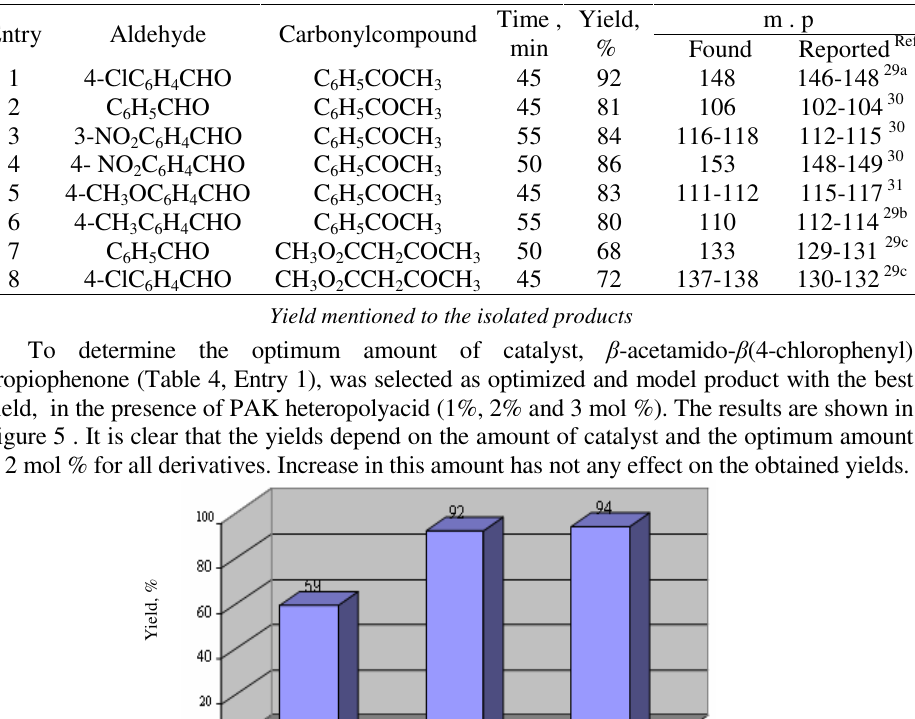
Table 4. synthesis of β -acetamido ketones and esters using catalytic amount of PAK under reflux condition